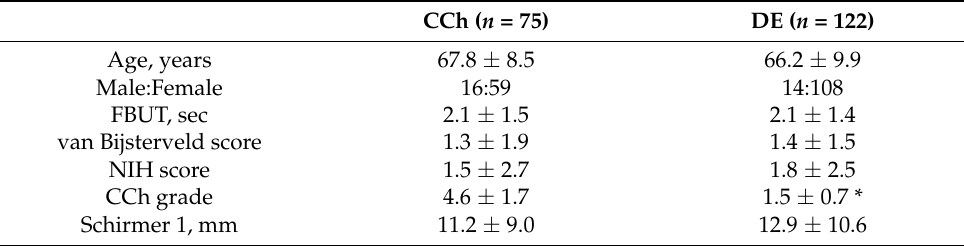
Table 1. Demographics and clinical characteristics of study